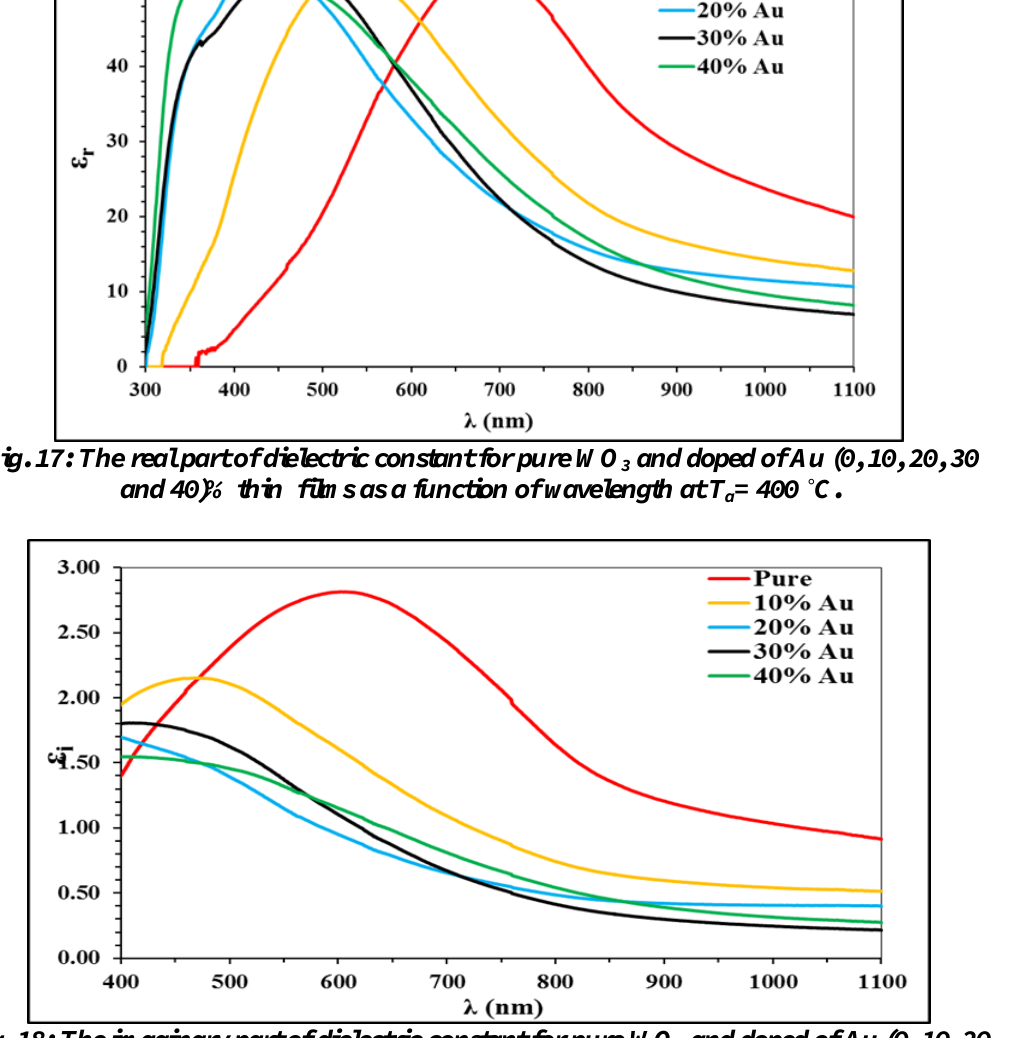
and doped of Au (0, 10, 20, 3 = 400 ˚C. a and 3